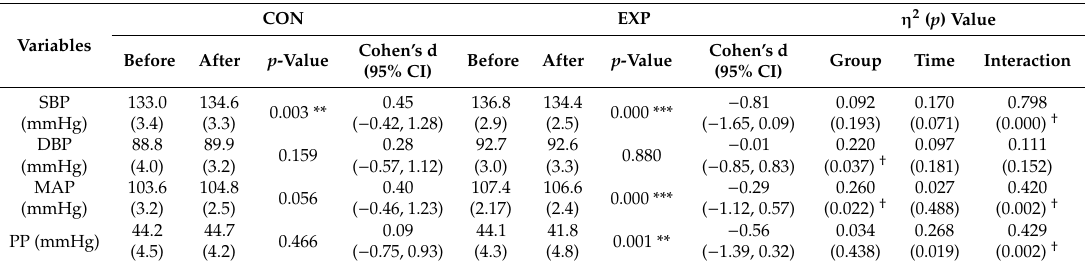
Table 3. Changes in blood pressure before and after 12-week intervention.